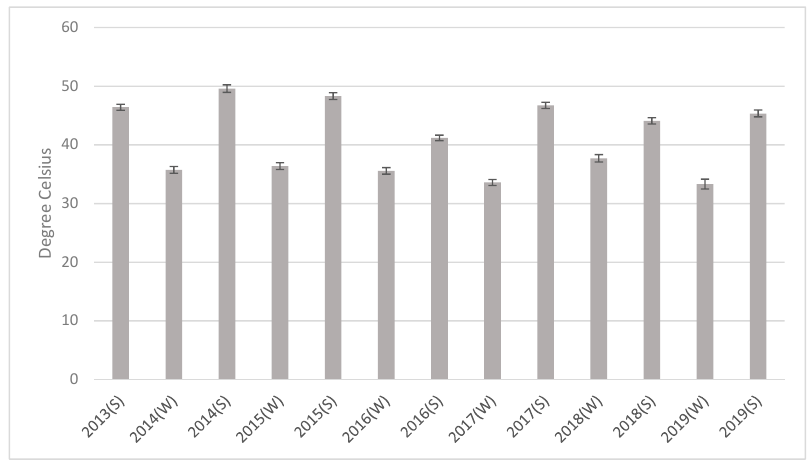
Figure 3. Seasonal variation of temperature across campus (degrees Celsius). Changes in land surface temperature (LST) during the summer and winter seasons (2013–2019).